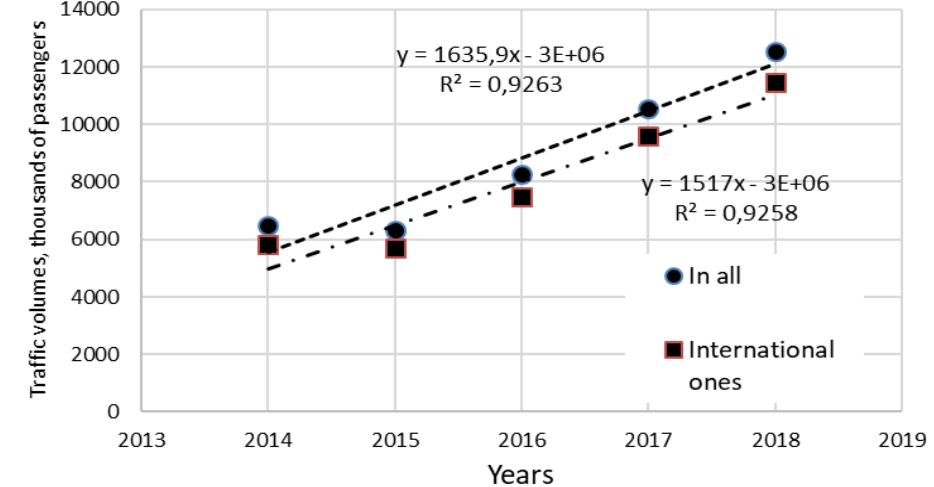
Figure 3. Estimation of growth rates of air transportation in Ukraine,